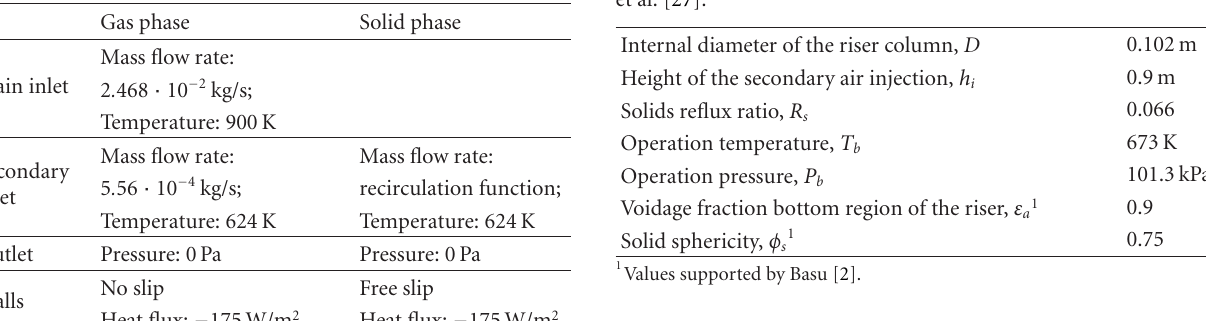
Table 5: Boundary conditions for the CFD riser simulation. Table 6: Input data used in the semiempirical model based on Hory et al.